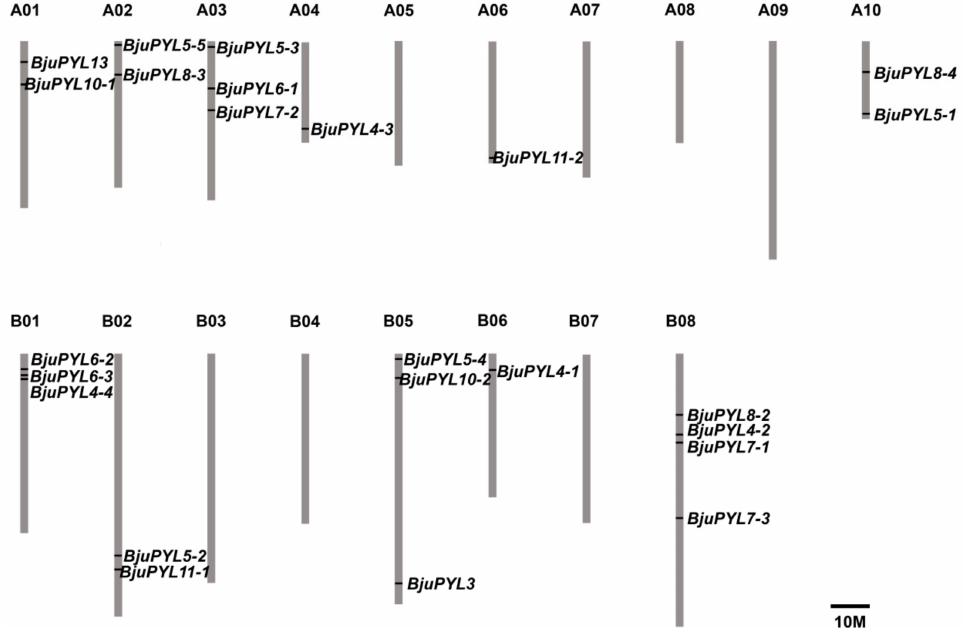
Figure 1. The distribution of BjPYLs in B. juncea var. tumida chromosomes. Twenty-five identified BjuPYLs were mapped to the 11 of 18 chromosomes. The chromosome name is at the top of each bar. The scale of the chromosome is in millions of bases